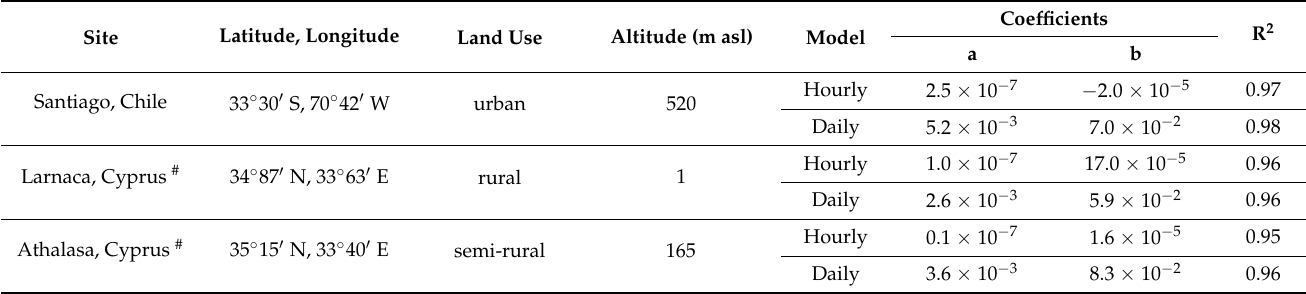
Table 7. Regression equation, coefficients, and R 2 for annual empirical models of hourly and daily values. Observations were carried out in Santiago during